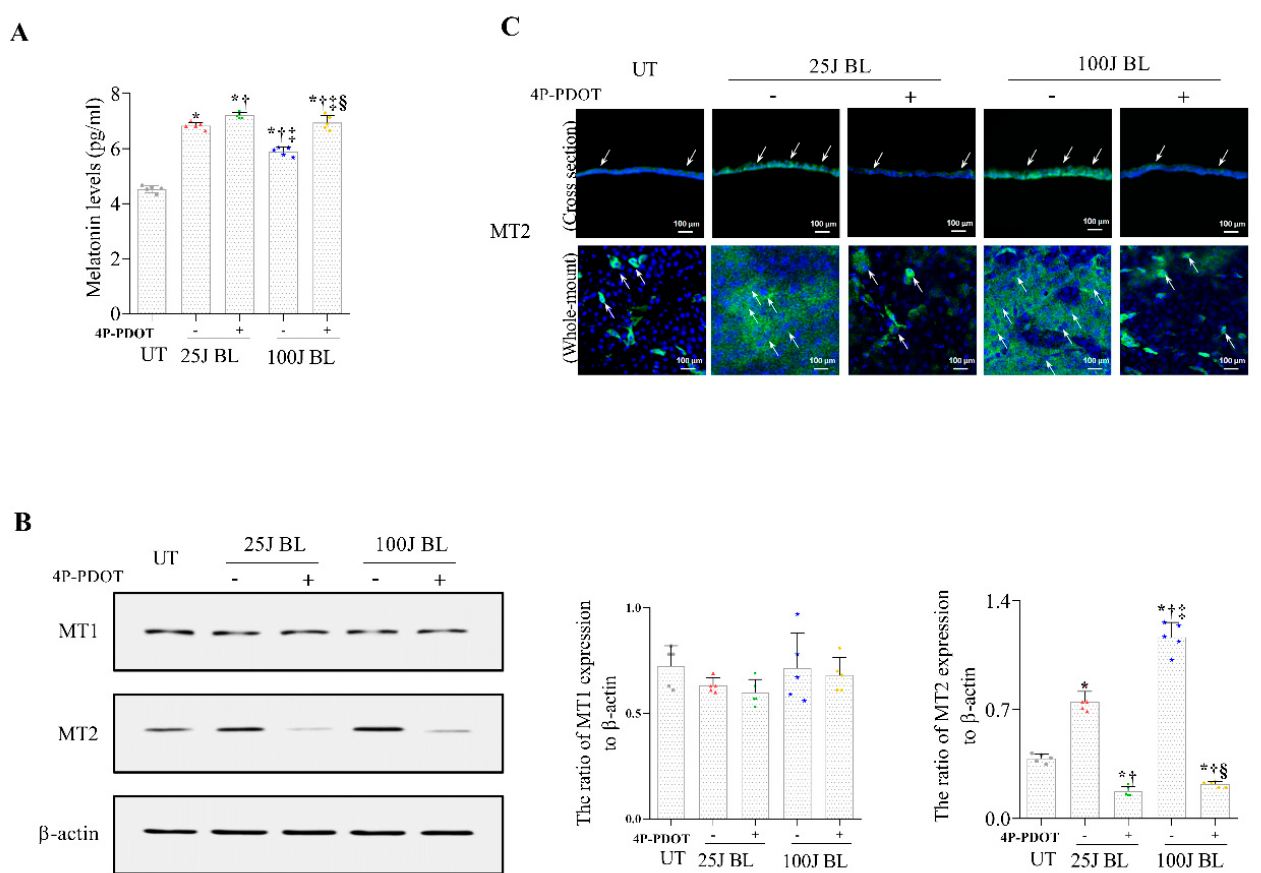
Figure 4. ELISA for melatonin levels ( A ) and Western blotting ( B ) for the expression of MT1 and MT2 in the cornea of the UT, 25 J BL, 25 J BL+4P-PDOT, 100 J BL, and 100 J BL+4P-PDOT groups, after 14 days of BL exposure. IHC ( C ) for MT2 expression in the mouse cornea treated or not treated with MT2 antagonist at day 14 of BL induction. * p < 0.05 vs. UT, † p < 0.05 vs. 25J BL, ‡ p < 0.05 vs. 25J BL+4P-PDOT, § p < 0.05 vs. 100 J BL; UT, untreated; BL, blue light.